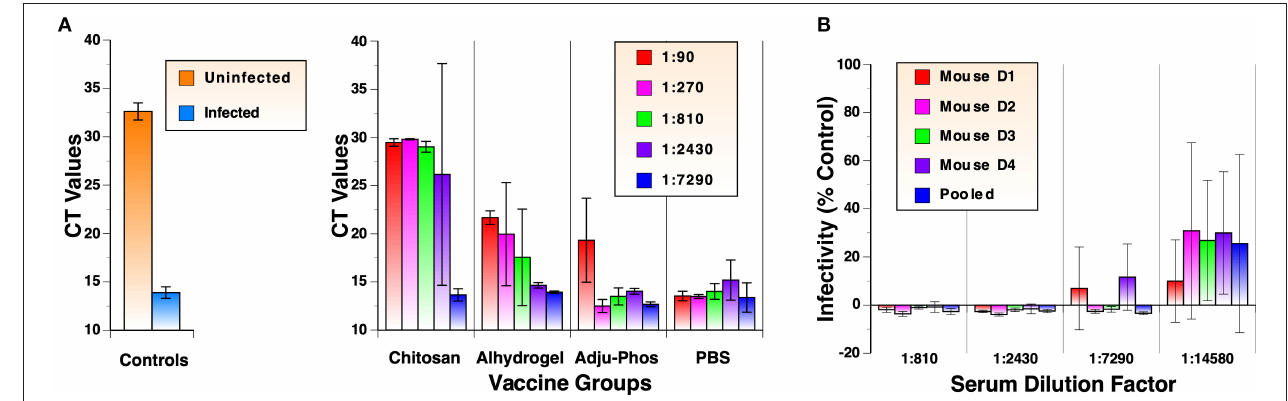
FIGURE 4 | Detailed analyses of neutralizing antibody responses. (A) RT-qPCR analyses of virus neutralization assay. Cell culture supernatants from neutralization assays using antisera after the 2nd immunization were evaluated in triplicate. Viral RNA was harvested from culture media of virus-infected cells. Following reverse transcription, qPCR was carried out using IDT 2019-nCoV RUO Kit. (B) Extended nAb titration of antiserum from individual mouse in the Alhydrogel group after 3rd immunizations. Pooled sera were also analyzed for